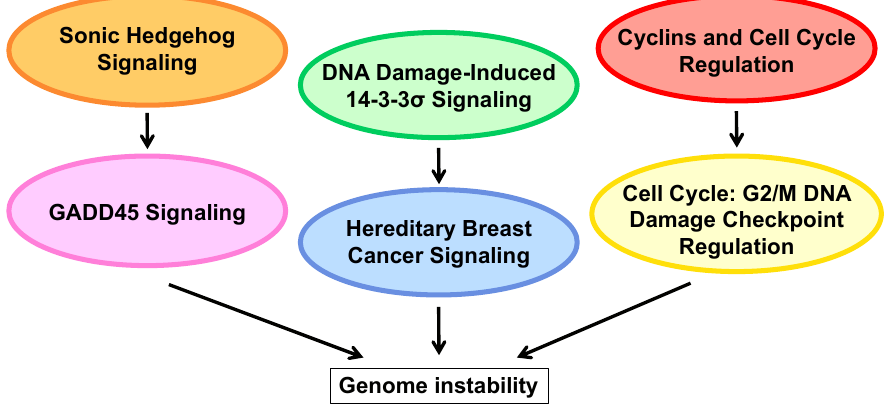
Figure 1. HDV-associated HCC has a unique molecular signature characterized by an enrichment of upregulated genes involved in cell-cycle/DNA replication, and DNA damage and repair, pointing to genome instability as an important mechanism of HDV hepatocarcinogenesis.